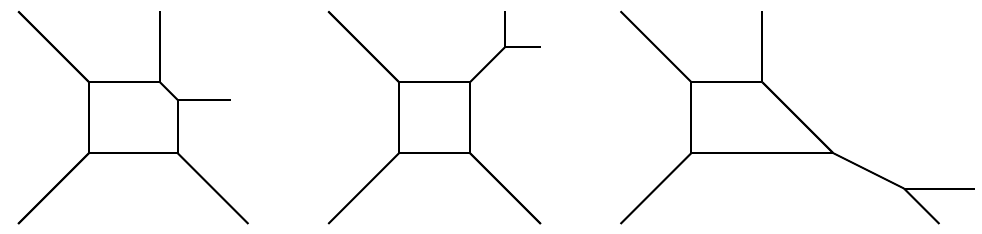
Figure 11. Left: 5-brane web diagram for SU(2) +1 F . Middle: decoupling the hypermultiplet by giving it a positive mass. Taking the mass to infinity results in the web diagram for pure SU(2) 0 theory. Right: decoupling the hypermultiplet by giving it a negative mass. Taking the mass to negative infinity results in the web diagram for pure SU(2) π